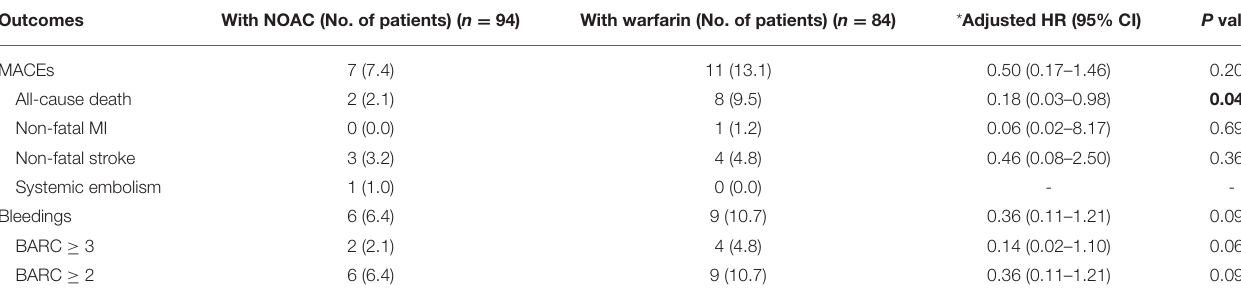
TABLE 3 | Risk of adverse clinical outcomes in patients with warfarin or with NOAC. Outcomes With NOAC (No. of patients) ( n = 94) With warfarin (No. of patients) ( n =